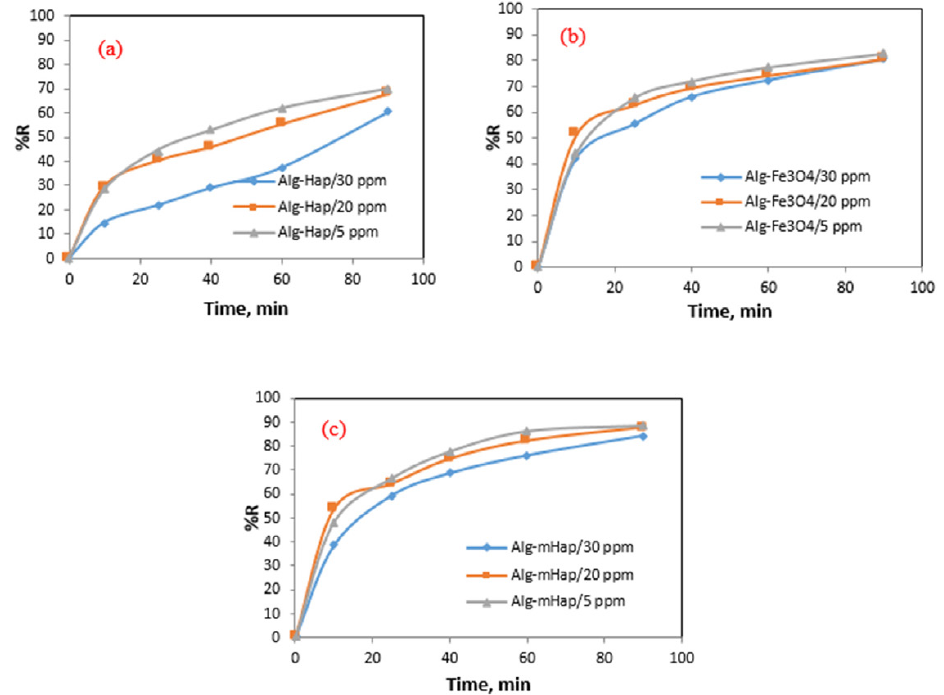
Fig. 7. Effect of initial cefixime concentration on cefixime removal (a) Alg-Hap, (b) Alg-Fe